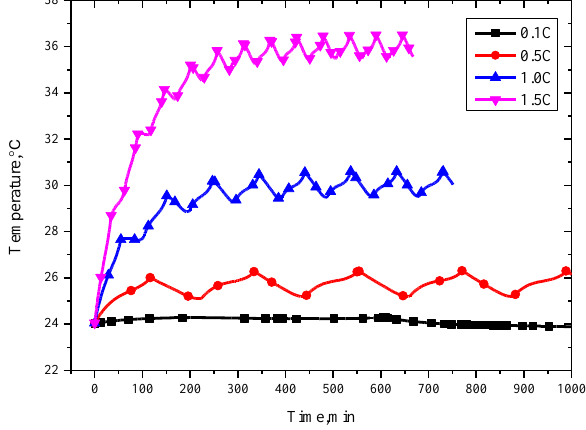
Figure 5. The temperature change under current rates of 0.1, 0.5, 1.0 and 1.5 C